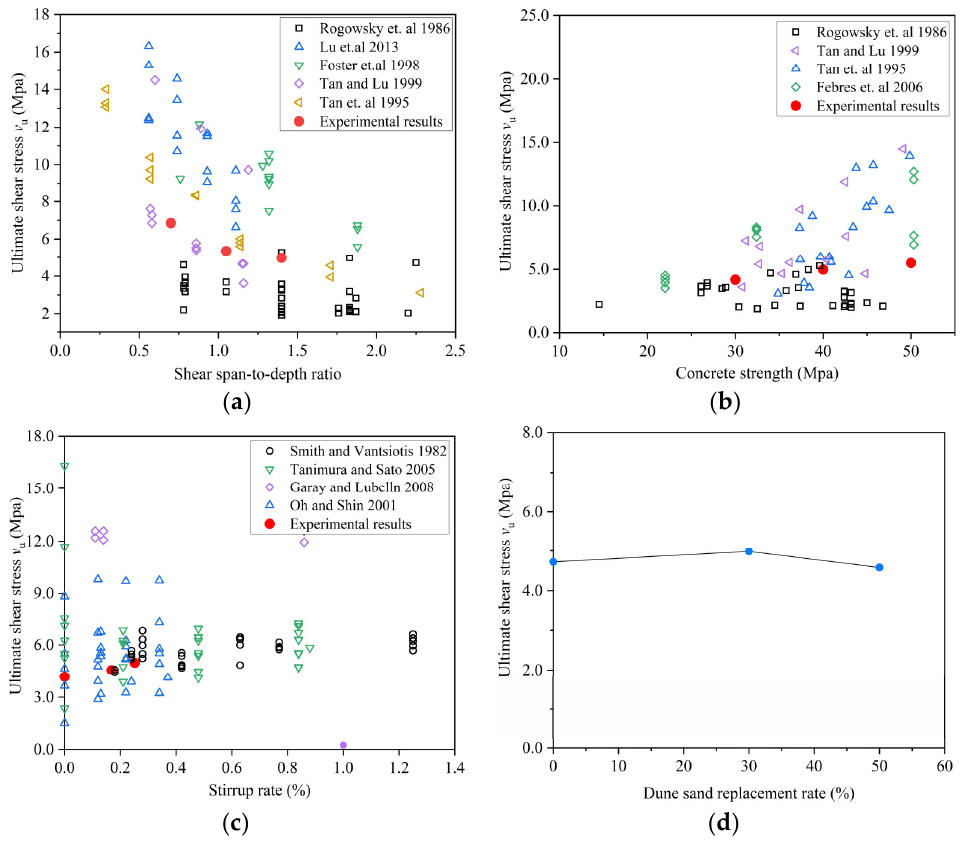
Figure 8. The shear stress v u versus ( a ) shear span-to-depth ratio, reported by this paper and the included studies [46–50]; ( b ) concrete strength, reported by this paper and the included studies [46,49–51]; ( c ) stirrup rate, reported by this paper and the included studies [52–55]; ( d ) dune sand replacement